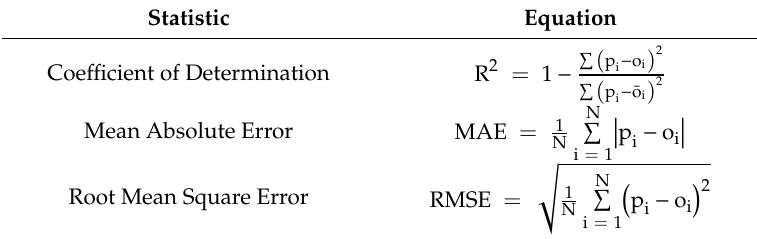
Table 4. Statistics used to compare the model’s performance in regression analysis; p is value derived from remote sensing (Vis and S2_BVs) and o is the observed value (BVs). ¯O is the mean value of o based on N